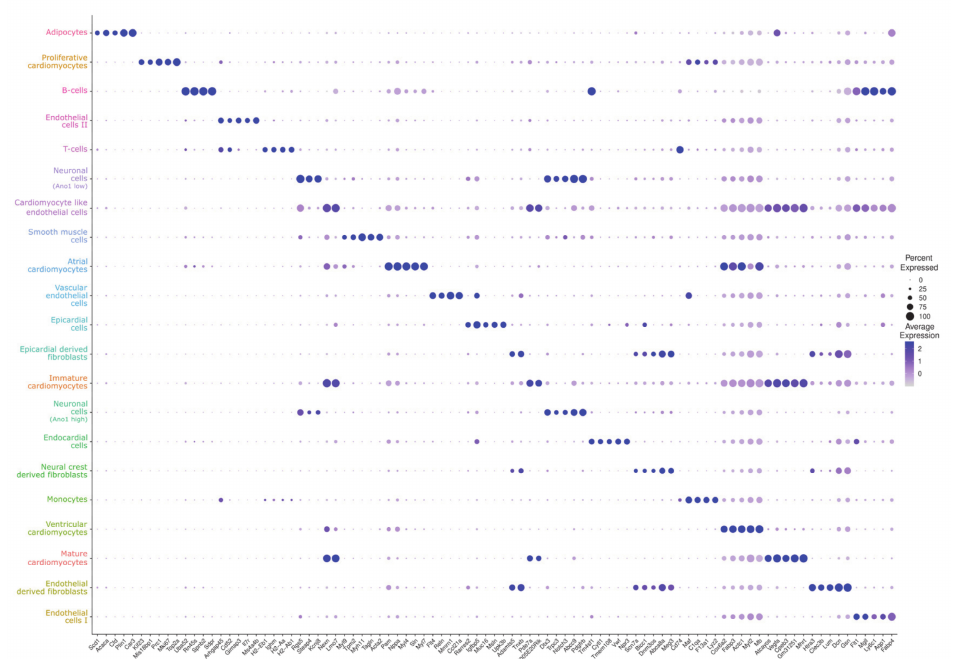
Figure 3. Dot plot of the top five markers for each identified cluster. For each cluster, the relative gene expression in percent is represented by the size of dots, e.g., a value of 100 means that each cell within this cell type expressed this gene. The average expression level for the listed genes is indicated by the